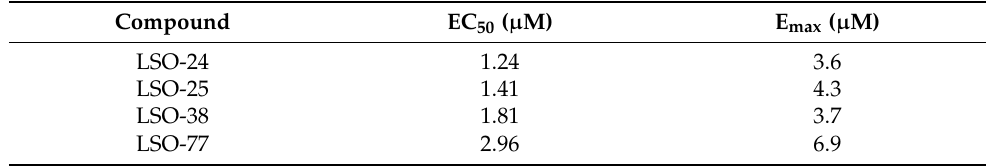
Figure 2. Search of novel R334W-CFTR potentiators by a high-throughput screening assay. ( A ) Schematic flow of the HS-YFP assay. CFBE cells co-expressing R334W-CFTR and the HS-YFP were acutely stimulated (30 min) with Fsk (5 µ M) plus test compound. DMSO, VX-770 (1 µ M), and Gen (50 µ M) were used as negative and positive controls, respectively. ( B ) CFTR function was assessed based on the cell-fluorescence quenching rate and normalized to the negative control. Data are represented as means + SD of 4 independent experiments: * p < 0.05 vs. DMSO. ( C ) Chemical structure of active compounds: LSO-24, LSO-25, LSO-38, and LSO-77. Table 1. EC 50 and E max of Active LSO Compounds.